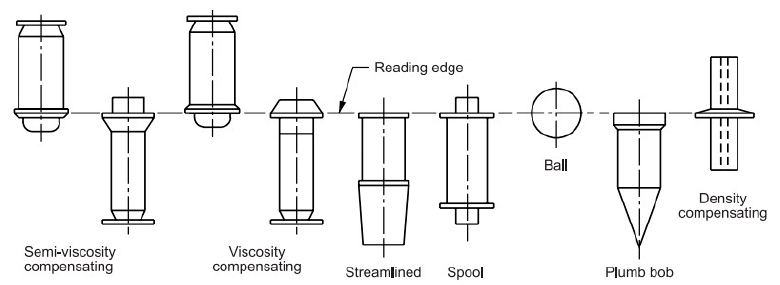
Figure 14. The exemplary types of floats. Table 1. The exemplary comparison of the flow rate values read on the rotameters and the PLC meter.